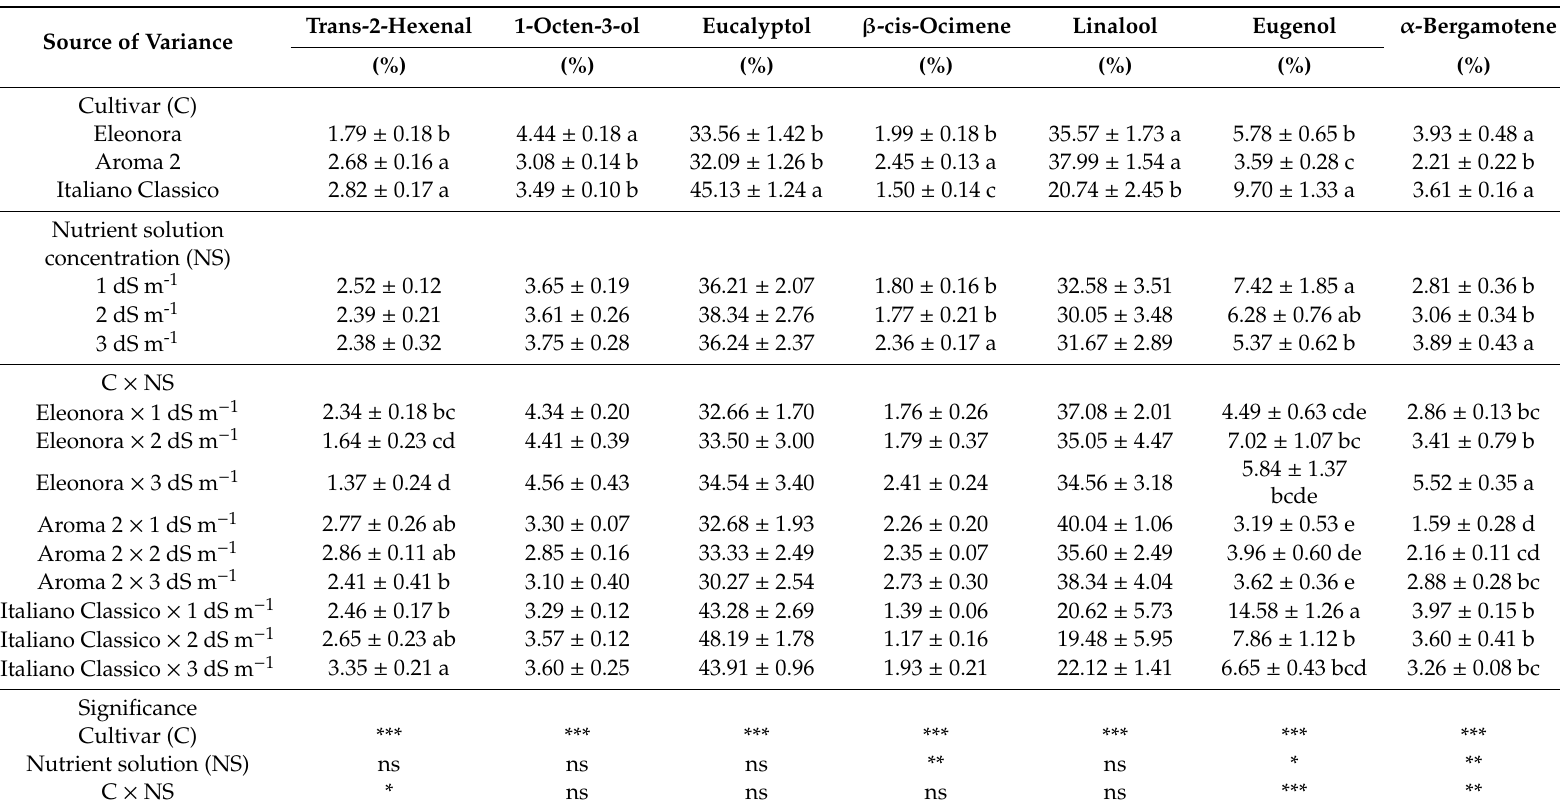
Table 3. Sweet basil aromatic profile in light of the cultivar and the nutrient solution electrical